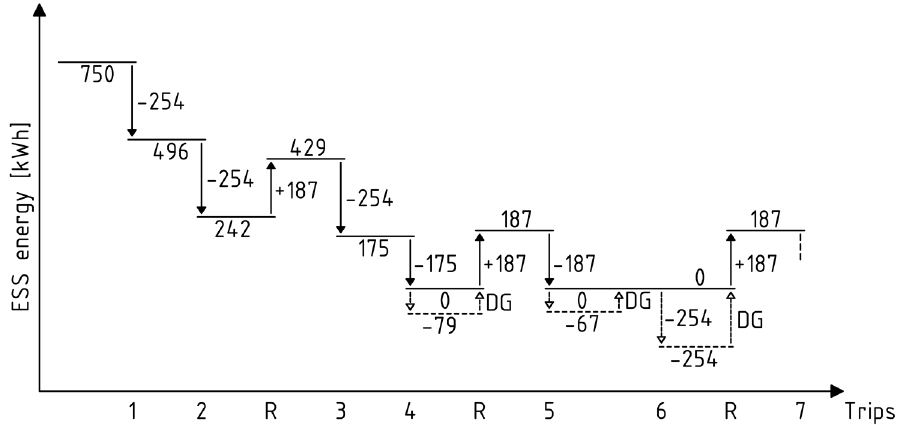
Figure 4. Energy stored in the ESS, consumption and recharge (R) during a working day, single MV-SC (case (c).